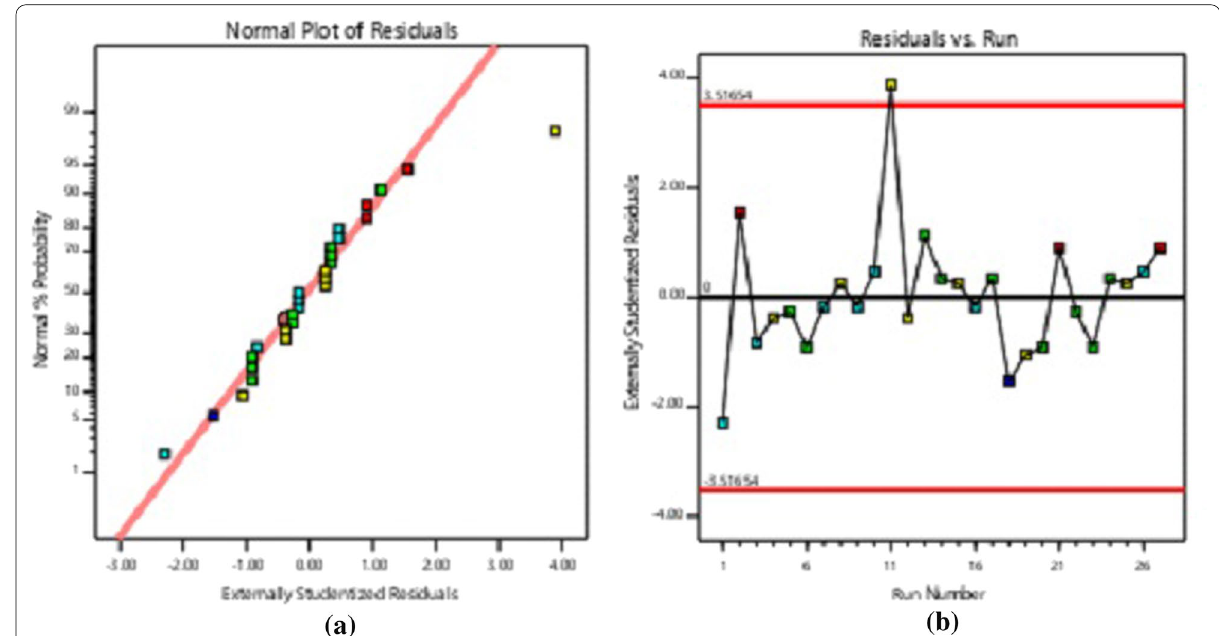
Fig. 6 Plot a showing true verses predicted values and residual plot b for the response